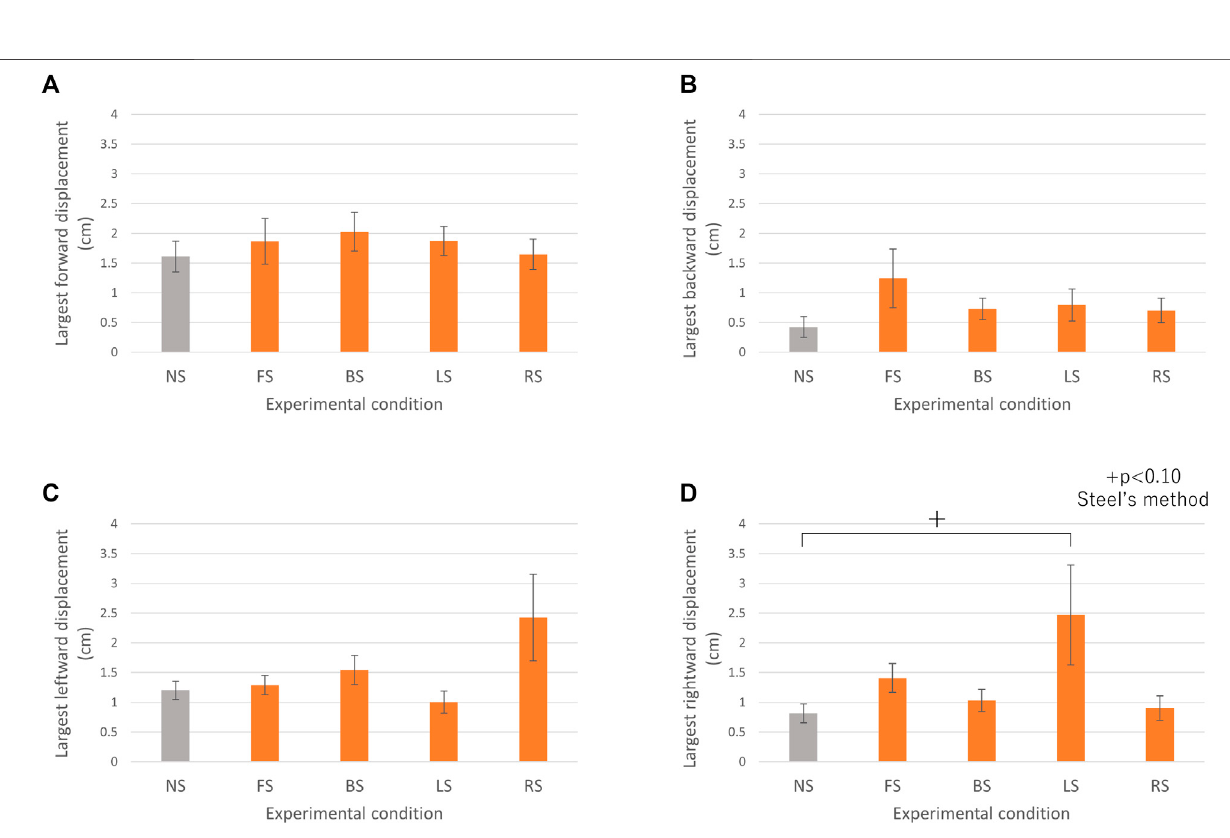
Frontiers in Virtual Reality |